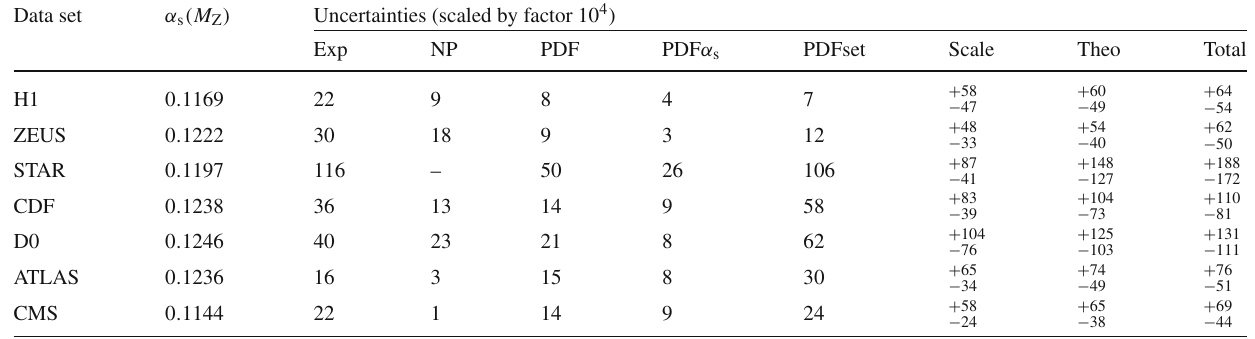
Table 5 Results of common-type α s ( M Z ) extractions from individ- ual inclusive jet data sets using the NNPDF3.0 PDF set. The values for α s ( M Z ) are provided along with the experimental and theoretical uncertainties. The latter consist of contributions originating from NP